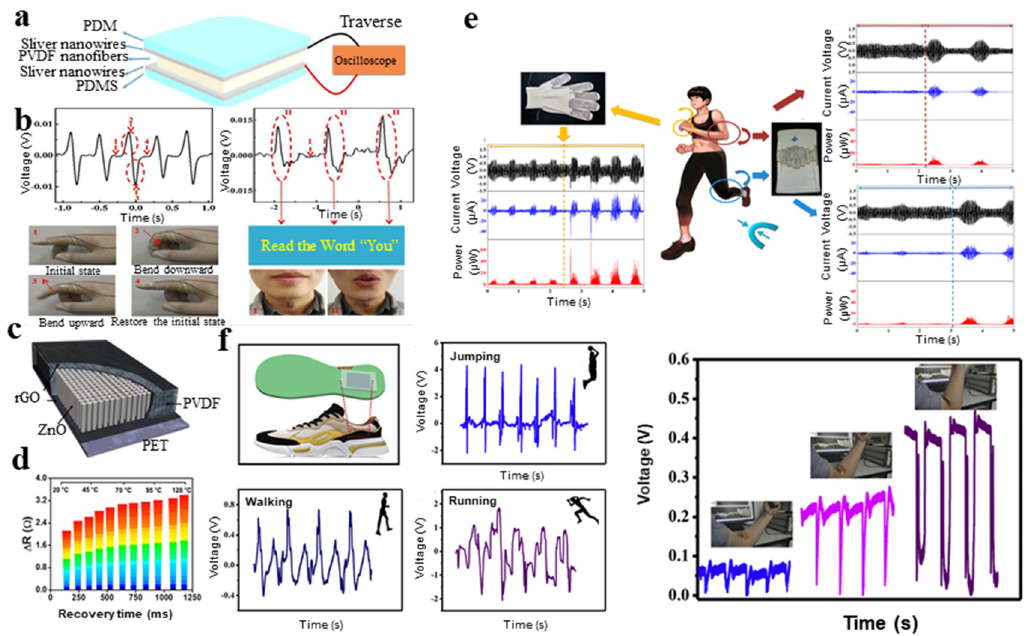
Figure 11. ( a ) Schematic of flexible pressure sensor used to detect pressure signal [130]; ( b ) device was used as a motion sensor to monitor knuckle bends and vocal cord vibrates [130]; ( c ) schematic of sensor based on PVDF and ZnO nanostructures on graphene electrodes [87]; ( d ) the relationship between temperature and recovery time [87]; ( e ) generated output voltages, output currents and output powers by finger bending as well as knee and elbow movements [143]; and ( f ) pressure sensor embedded in the bottom of the insole or stuck on human arm and voltage generated by jumping, walking, running and different bending angles’ elbows [116].